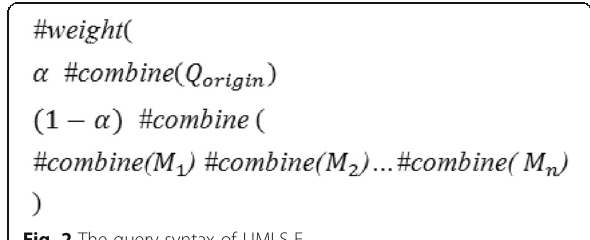
Fig. 4 The effect of α value on UMLS-E and